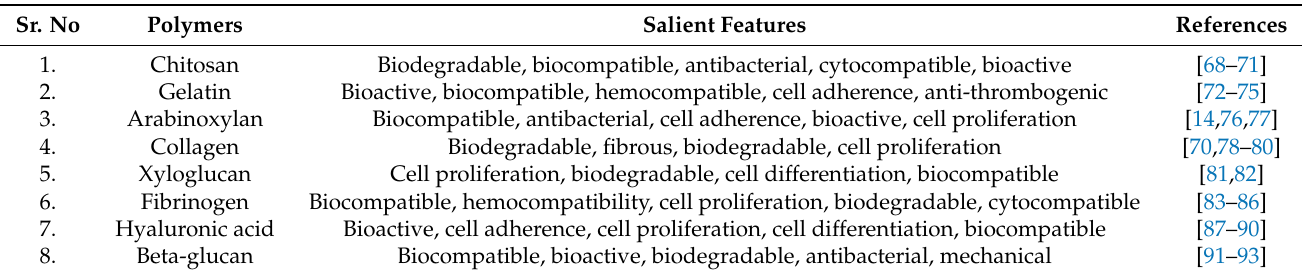
Table 1. Polymeric composite materials in tissue